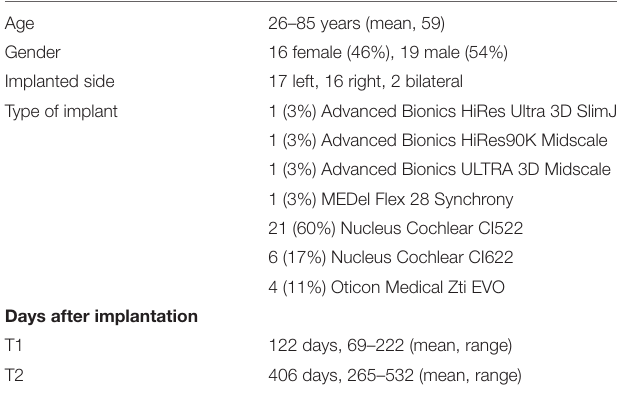
TABLE 1 | Demographic characteristics of the 35 study